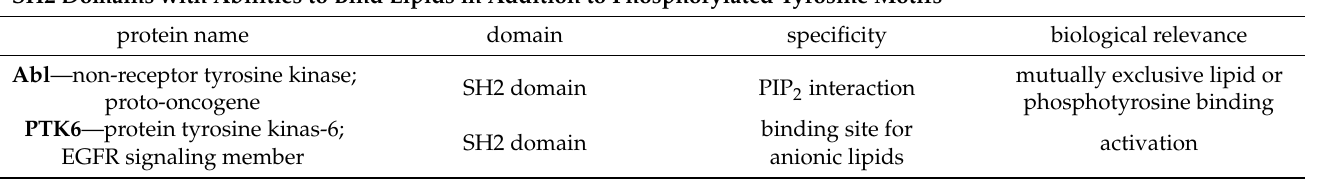
Table 1. Overview of the non-conventional, lipid-binding SH2 and SH3 domain-containing proteins discussed throughout the text. SH2 Domains with Abilities to Bind Lipids in Addition to Phosphorylated Tyrosine